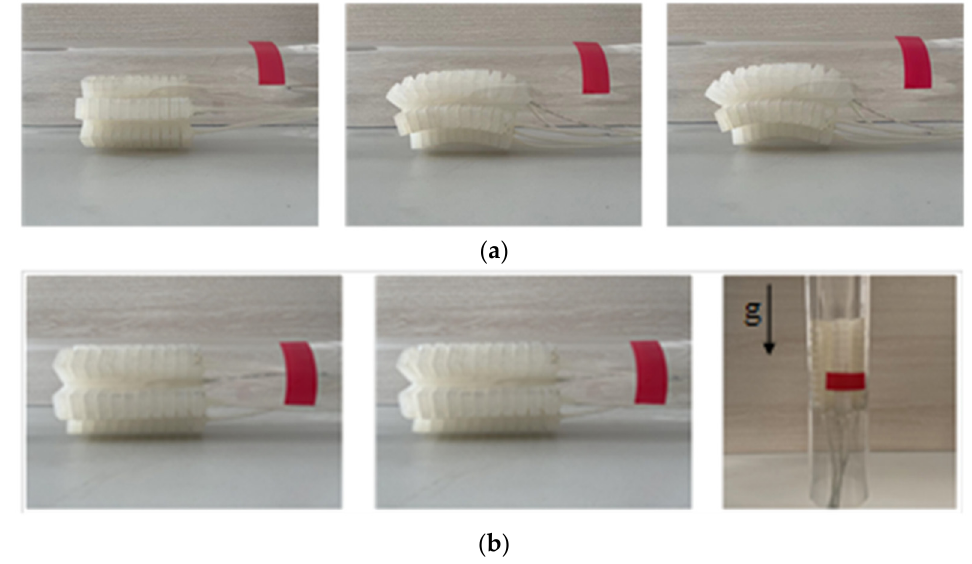
Figure 11. Pipe deformation diagram of hexagonal prism soft-bodied bionic actuator. ( a ) The actuator bends and deforms in the pipe. ( b ) The actuator expands and deforms in the pipe. give the actuator stability in the